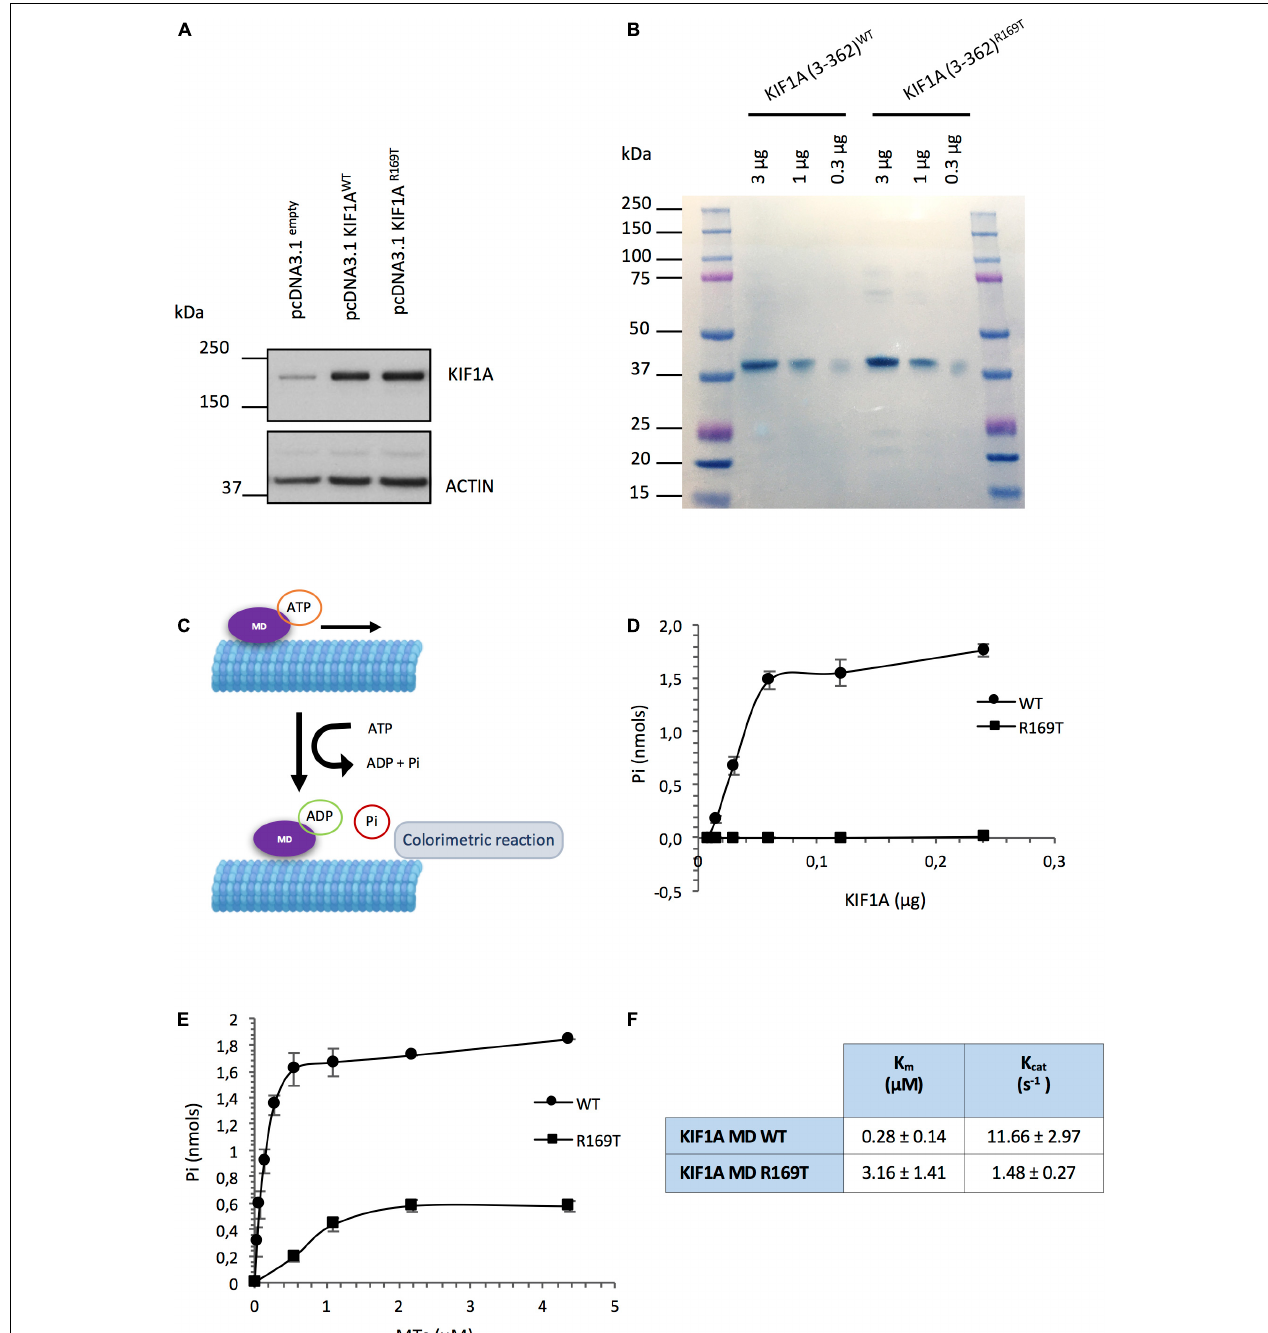
FIGURE 2 | Functional assays carried out with the R169T variant. (A) Overexpression of full-length KIF1A WT and R169T in SH-SY5Y neuroblastoma cells. Cell lysates were harvested 96 h post-transfection. Thirty micrograms of protein corresponding to SH-SY5Y cells transfected with pcDNA3.1 empty , pcDNA3.1 KIF1A WT , and pcDNA3.1 KIF1A R 169 T vectors loaded. Actin was used as a loading control. (B) Naphthol Blue staining of the PDVF membrane showing that the same amount of protein corresponding to WT and R169T has been used for the ATPase assay. (C) ATPase activity assay diagram. (D) Microtubule-stimulated ATPase activity of the WT and R169T motor domains. A range of 0.0078–0.24 µ g of recombinant protein was used in the assay. To start the ATPase reaction, 10 µ l of taxol-stabilized microtubules (0.2 mg/ml) and 10 µ l of ATP 100 mM ATP PIPES pH 7.0 were added to each well and incubated 5 min at room temperature. The readout at 650 nm was performed after a 10-min incubation of the reactions with 70 µ l of CytoPhos termination reagent. (E) ATPase activity in the presence of increasing concentrations of microtubules. A range of 0–4.375 µ M of microtubules was used. Data were fitted by linear regression. K m and V max were determined according to the Lineweaver Burk equation. K cat was determined by K cat = V max /[total enzyme concentration]. Pi, inorganic phosphate; MTs, microtubules. (F) K m and K cat values of KIF1A motor domain (MD) WT and R169T.